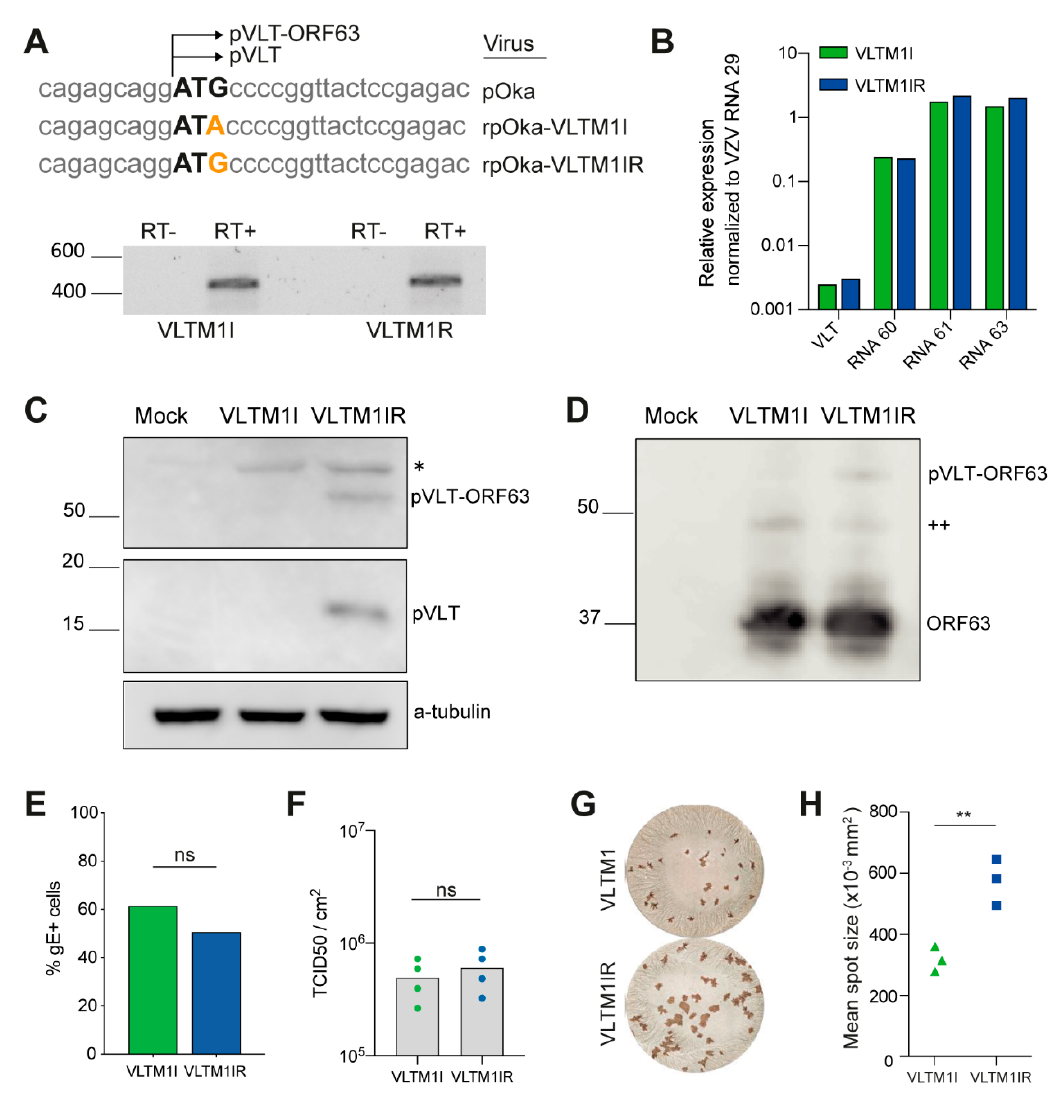
Figure 6. Generation of VZV pVLT/pVLT-ORF63 mutant viruses using BAC mutagenesis. ( A ) Top: Nucleotide sequence of VZV pOka, rpOka-VLTM1I and rpOka-VLTM1IR of the pVLT/pVLT-ORF63 ATG start codon in black, mutations in orange and its flanking regions and bottom: RT-PCR on RNA isolated from ARPE-19 cells infected with VZV VLTM1I or VLTM1IR using primers located in VLT exon 1 and exon 5. RT-/RT+: reverse transcriptase omitted or added in cDNA synthesis. ( B ) Relative expression level of VLT RNAs, RNA 60, RNA 61 and RNA 63 in ARPE-19 cells asynchronously infected with VLTM1I or VLTM1IR. Expression levels were normalized to VZV RNA29 to compensate for differences in infection. ( C , D ) Western blots on lysates of mock-, VZV VLTM1I- or VZV VLTM1IR-infected ARPE-19 cells stained with anti-pVLT, anti-alpha-tubulin ( C ) and anti-pORF63 ( D ) antibodies. Bands for pVLT and pVLT-ORF63 are indicated, * signifies an nonspecific band detected in all virus-infected cells, ++ indicates pORF63-N+ [10]. ( E ) Percentage VZV glycoprotein E (gE)–positive cells by flow cytometry of VZV VLTM1I and VLTM1IR in ARPE-19 cells at 72 hpi. Representative data for n = 2 independent experiments, n = 3 technical replicates. ns, not significant by unpaired Student’s t -test. ( F ) Cell-associated VZV titers of monolayers infected with VLTM1I or VLTM1IR virus at 72 hpi as measured by TCID50 per cm2, ns: not significant by unpaired Student’s t -test. ( G , H ) Infectious focus assay of VZV VLTM1I and VLTM1IR-infected ARPE-19 cells at 6 days post-infection ( n = 2 independent experiments, 4 replicates each). ( G ) Representative images of infected wells stained for VZV gE by immunohistochemistry and ( H ) Mean spot size ( × 103 mm 2 ) of VLTM1I (green) and VLTM1IR (blue) viruses per well, ** p < 0.01 by unpaired Student’s t